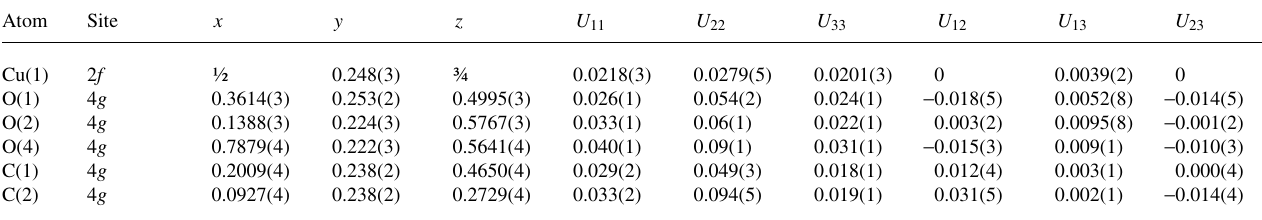
Table 3. Atomic coordinates and displacement parameters (in Å 2 )